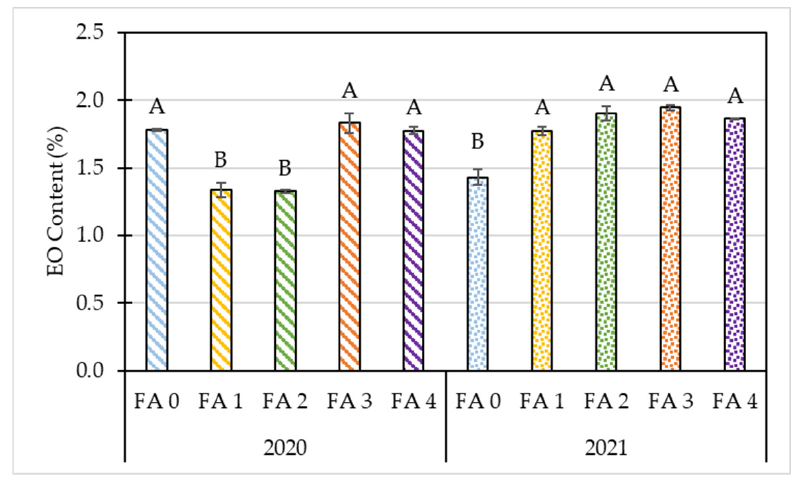
Figure 6. Influence of interaction Y × FA on essential oil (EO) content. FA0: only water; FA1: 8 g L − 1 of CaO; FA2: 12 g L − 1 of CaO; FA3: 8 g L − 1 of CaO + 16 g L − 1 of urea; FA4: 12 g L − 1 of CaO + 16 g L − 1 of urea. Values with different letters are significantly different at p ≤ 0.05 according to Tukey’s test. Bars represent the standard deviation.